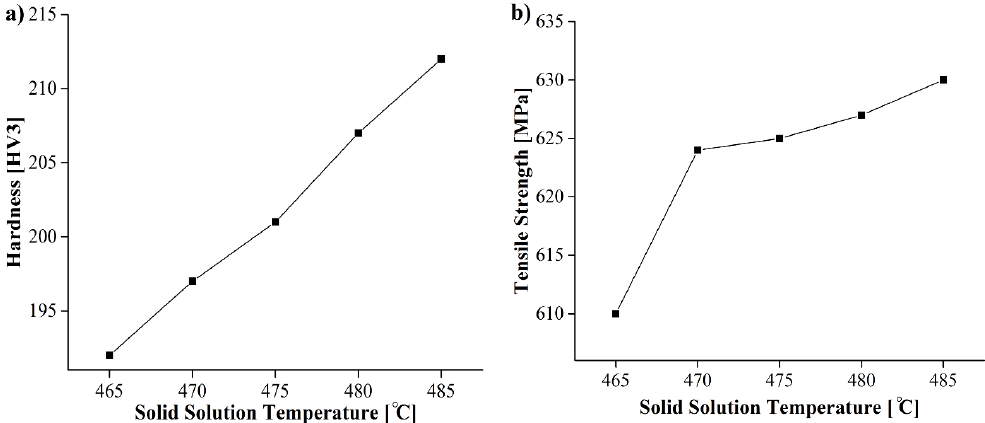
Figure 3: Hardness (a) and tensile strength (b) change of the AA7075 alloys after solid solution and age heat treatments.